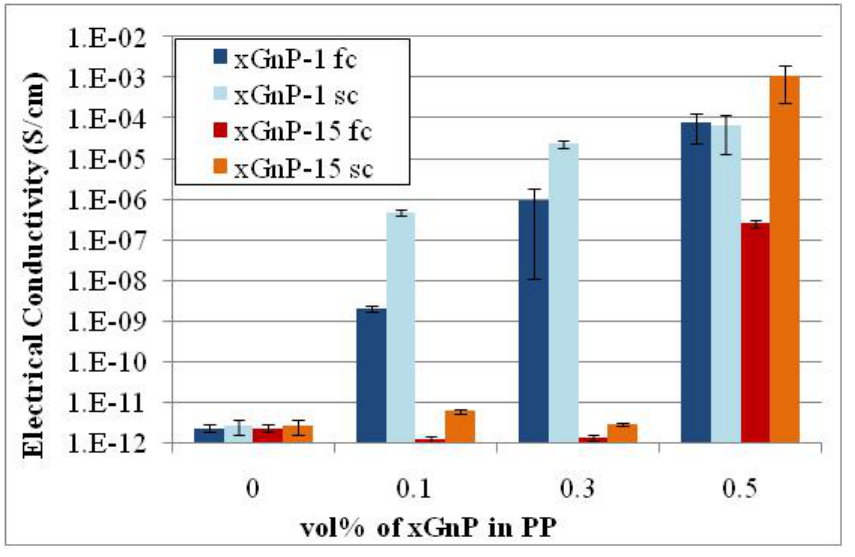
Figure 11. Effect of cooling rate (crystallization behavior of polymer matrix) on the electrical conductivity of xGnP/PP nanocomposites made by coating (premixing) and compression